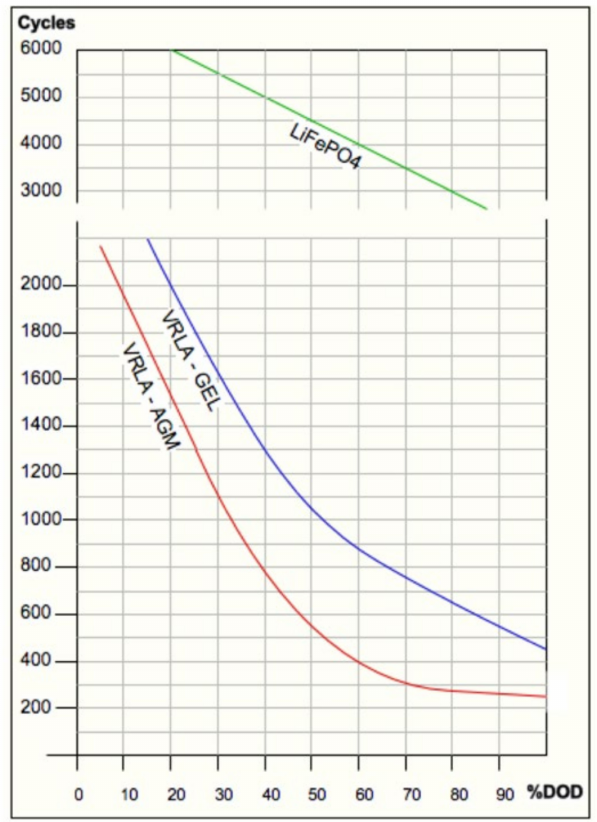
Figure 8. Battery duration to 60% SOH in charge–discharge cycles for different DOD and technologies.